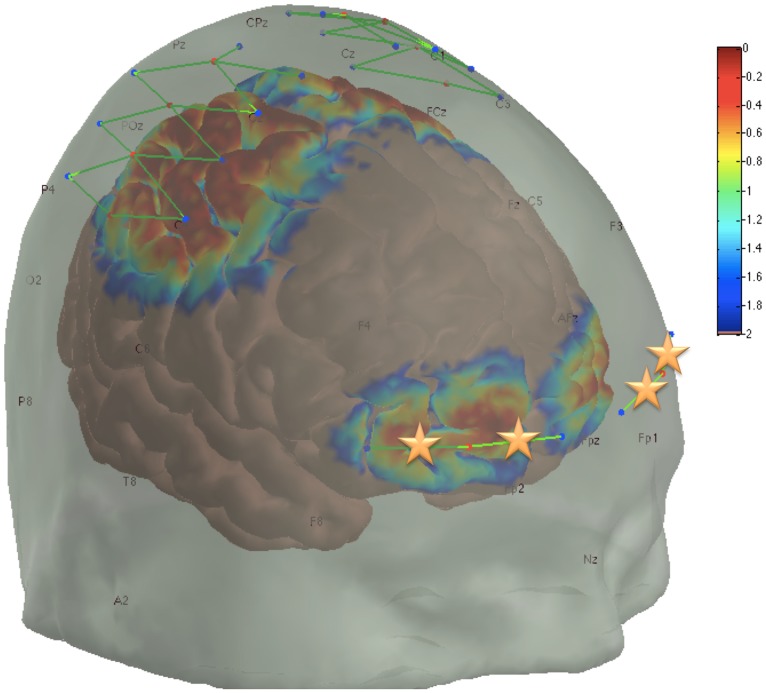
Sensor array and sensitivity profile.The fNIRS sensor array light sources (red dots), detectors (blue dots), and sensor channels (green lines) are shown at their intended locations. Although some shifting may occur for each subject, this has been shown to be sufficiently minimal in other studies where subject specific optode placements were measured. The sensitivity of the probe to detecting brain hemodynamics is shown as a logarithmic temperature plot ranging from 1.00 (0 dB, red) to 0.01 (-40 dB, blue) times the maximum sensitivity. The four frontal lobe channels used in this analysis are indicated with orange stars.